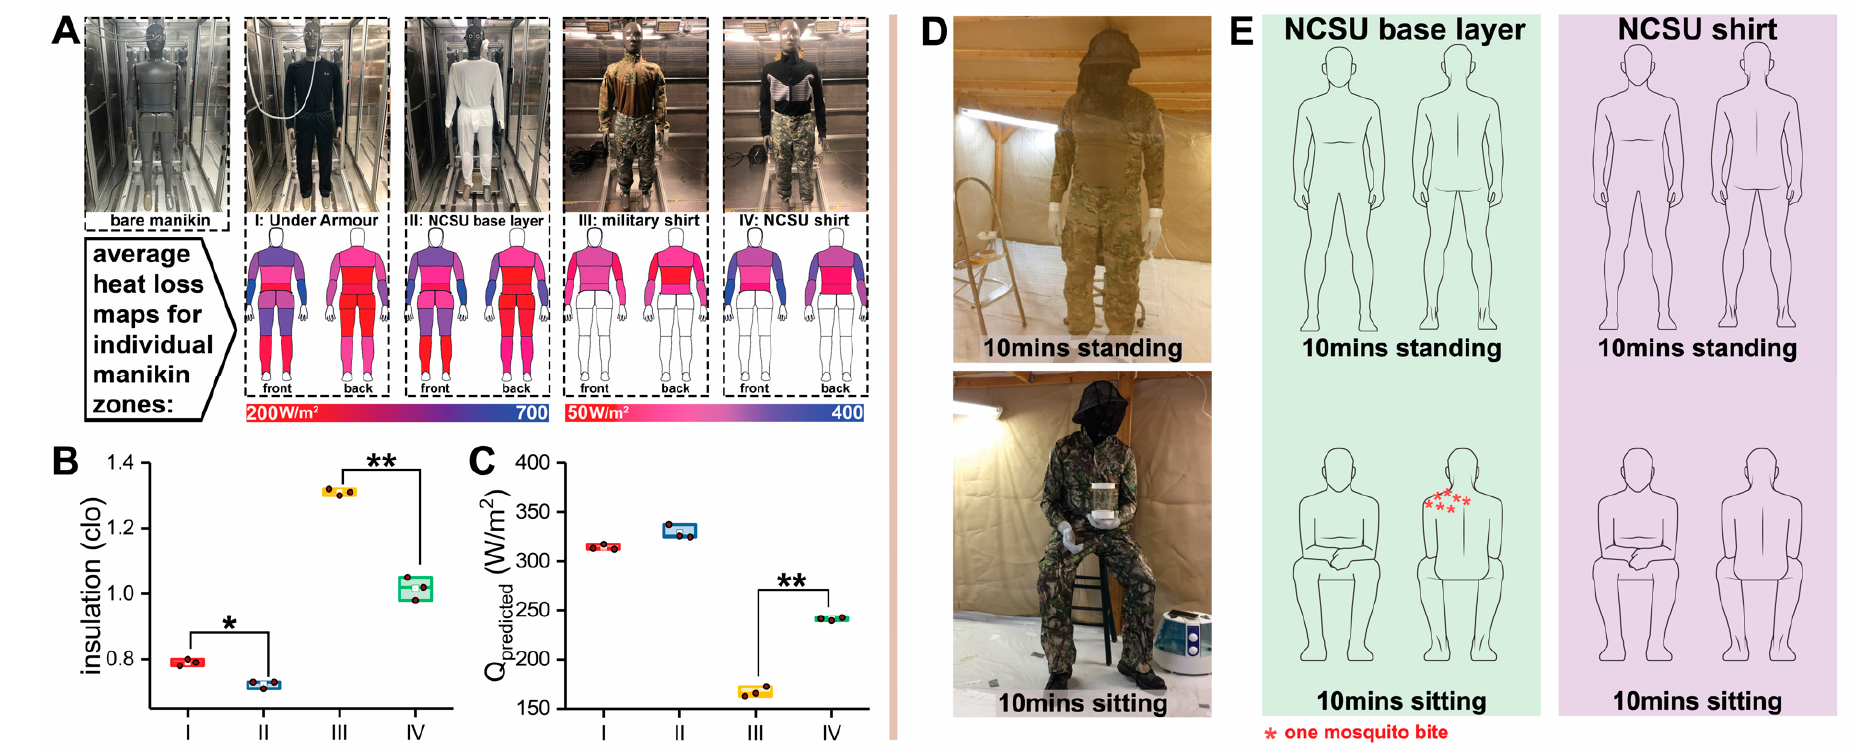
Figure 5. Prototype garment’s comfort and bite-resistance compared to commercially available similar garments. ( A ) Manikins equipped with various garments (I, Under Armour ® base layer; II, NC State base layer; III, winter army combat shirt; and IV, NC State shirt), also showing the average heat-loss maps. ( B ) Garment insulation. Since mosquitoes mostly appear in warm weather, a garment with low insulation properties is preferred. The NCSU base layer and NCSU shirt provided lower levels of insulation compared with the comparative garments tested ( p < 0.05 and p < 0.01, respectively). ( C ) The D predicted values (predicted heat loss; Table S1) for the garments tested. II the NCSU base layer showed an equivalent thermal and moisture management compared with I. IV, the NCSU shirt exhibited better thermal and moisture management compared to III ( p < 0.01). ( D ) Walk-in-cage bioassay with 10 min standing and 10 min sitting. The container in the hands of the subject (bottom picture) housed the mosquitoes. The mosquitoes were typically released, and the test started with the person standing (note the empty container on the stool, top picture). ( E ) Walk-in-cage bioassay results for the worst-case replicate shown (* = one mosquito bite). Bites on the shoulder were observed where the most stretching of the garment occurred and bite resistance was reduced. A specially designed double layer was used in this part of the NCSU base layer which eliminated all bites in the walk-in-cage bioassay (data not shown).